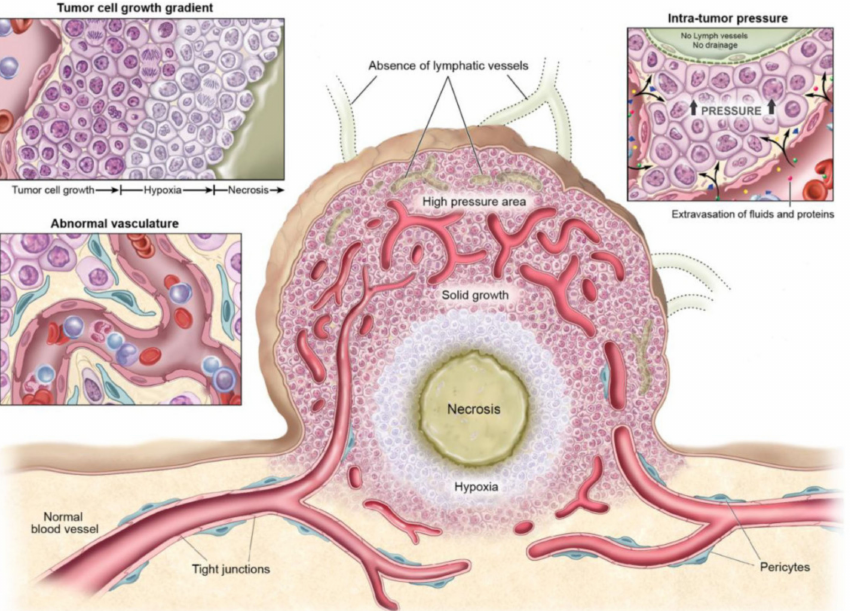
Figure 4. Physiological characteristics of a tumoral tissue. Reproduced with permission from